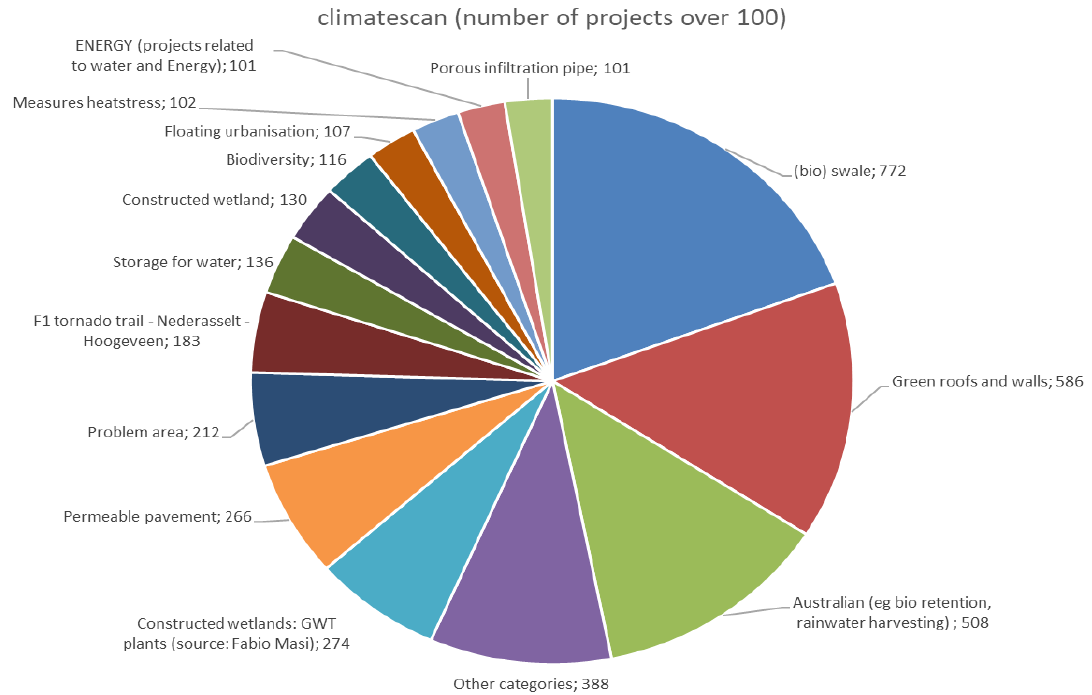
Figure 2. Overview of nature-based solutions uploaded to ClimateScan, to keep the figure readable only categories with more than 100 projects are depicted (based on ClimateScan database).